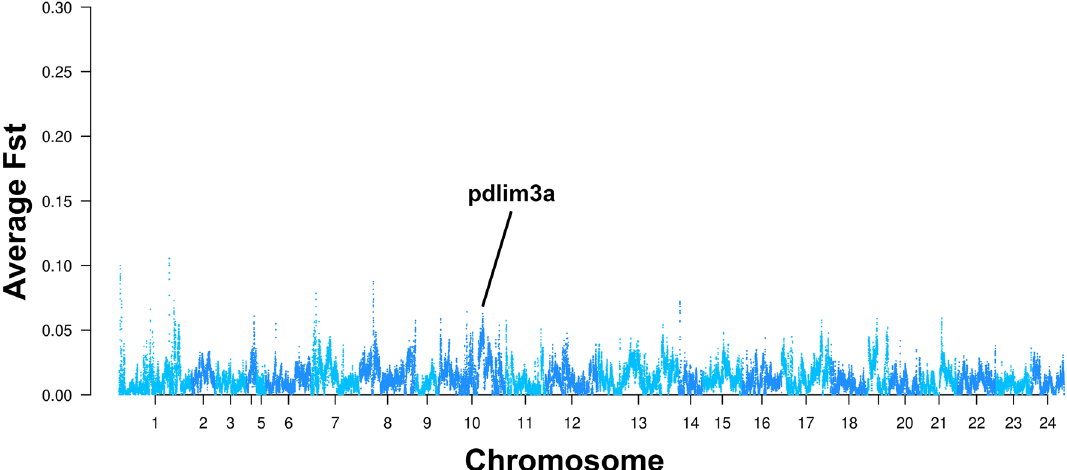
Figure 4. Genomic regions associated with regional differentiation of large yellow croaker between Zhoushan sea and Ningde sea. Manhattan plot for average Fst values in 40 kb windows with 10 kb steps between Zhoushan sea-captured population and Ningde sea-captured population. The x-axis represents chromosomal positions and the y-axis represents the average Fst